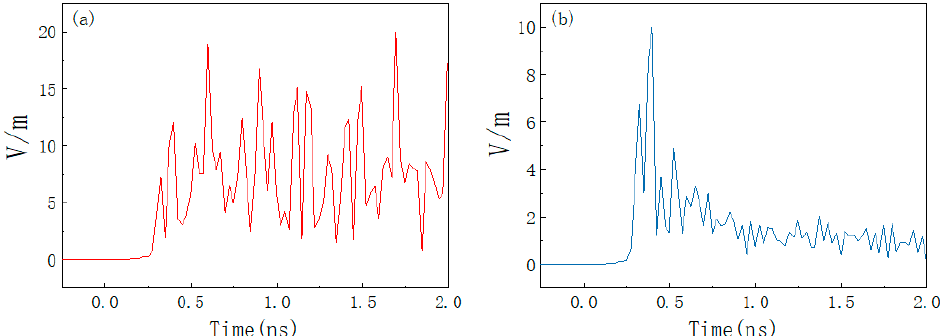
Figure 12. Electric field strength at the center of the product cavity under UWB amplitude illumina- tion. ( a ) No absorbing material; ( b ) placement of absorbing material.